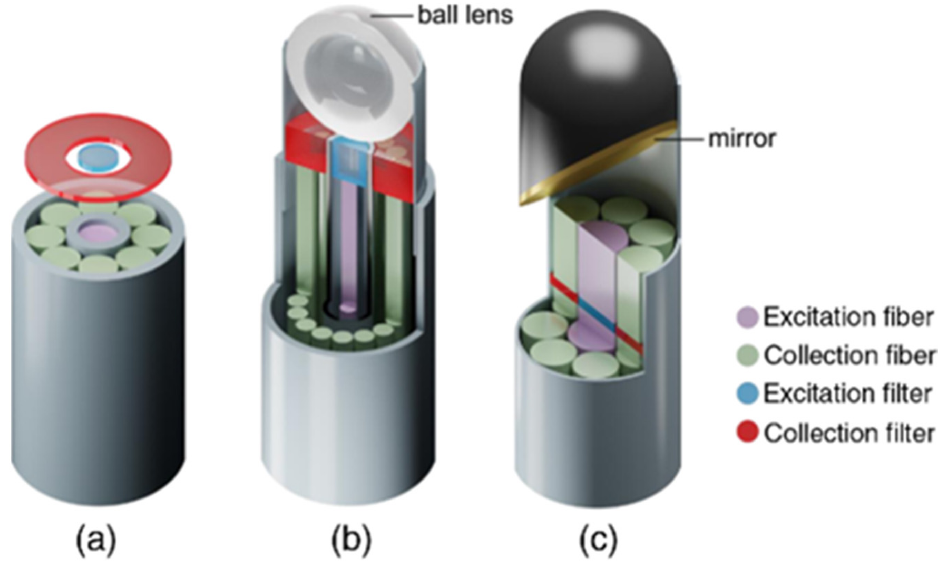
Figure 4. Different geometries of fiber-probes used in clinical applications: ( a ) non-superficial endoscopic probe with one excitation fiber in the center and seven collection fibers arranged around the emitter ( b ) confocal endoscopic fiber probe with a ball lens ( c ) fiber probes with mirror (or prisms) [87]. https://doi.org/10.1117/1.JBO.23.7.071210, access on 10 January 2022. PMID: 29956506. Excitation and collection filters are also depicted.